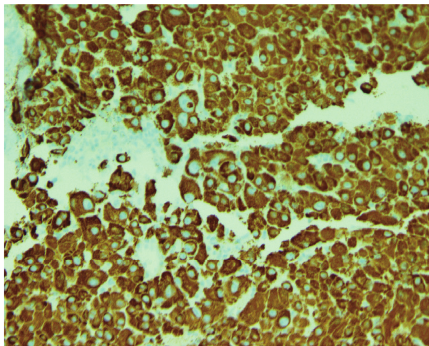
Figure 5: Hep Par-1 stain positive (histopathology and immu- nostaining of forehead lesion).